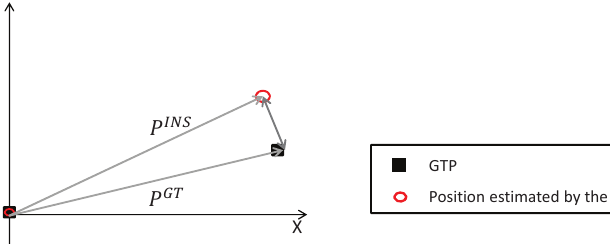
Figure 12. Representation of the position error between the true position of a GTP ( P GT ) and its estimated position ( P INS ).